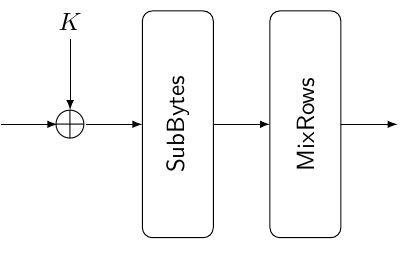
Figure 1: The state of Pyjamask-96 .